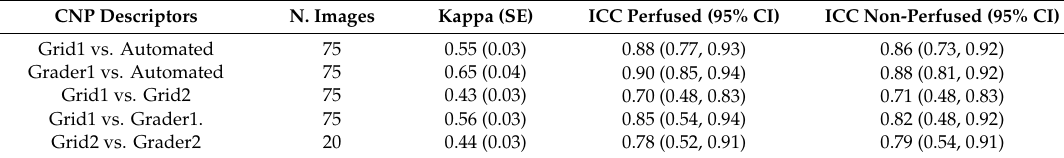
Table 1. Comparative of grid assessment of CNP (Grid1: manual grid assessment by grader 1, Grader 2: manual grid assessment by grader 2, AI expert: automatic assessment of AI expert dense segmentation, Grader1: automatic assessment of manual dense segmentation by grader 1, Grader 1: automatic assessment of the dense segmentation by grader 1, Grader 2: automatic assessment of the dense segmentation by grader 2, SE: standard error, CI: confidence interval).